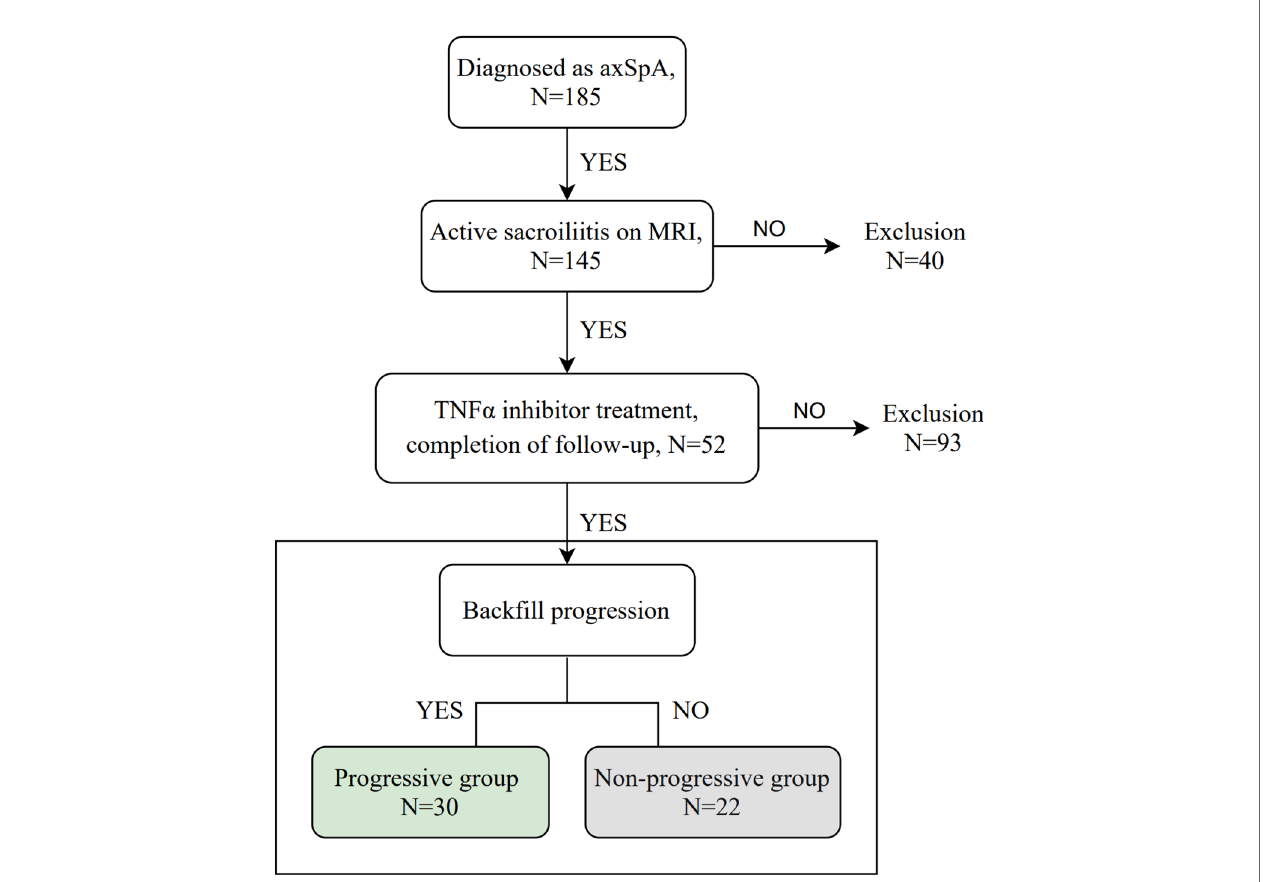
FIGURE 1 | Flowchart of the study. axSpA, axial spondyloarthritis; MRI, magnetic resonance imaging; TNF a , tumor necrosis factor